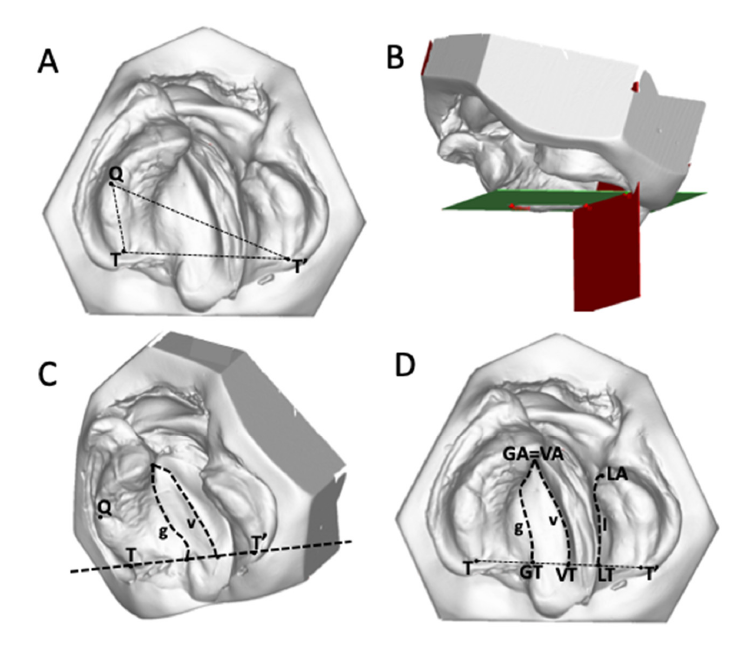
Figure 1. Establishment of a three-dimensional coordinate system. ( A ) and ( B ) A horizontal plane (green) is defined by (Q, T, T’), and a vertical plane (red) is defined by (T, T’). ( C ) and ( D ) The line between VT–VA denotes the vomer edge (v), the line between GT–GA denotes the palatal shelf ridge of the greater segment (g), and the line between LT–LA represents the palatal shelf ridge of the lesser segment (l).